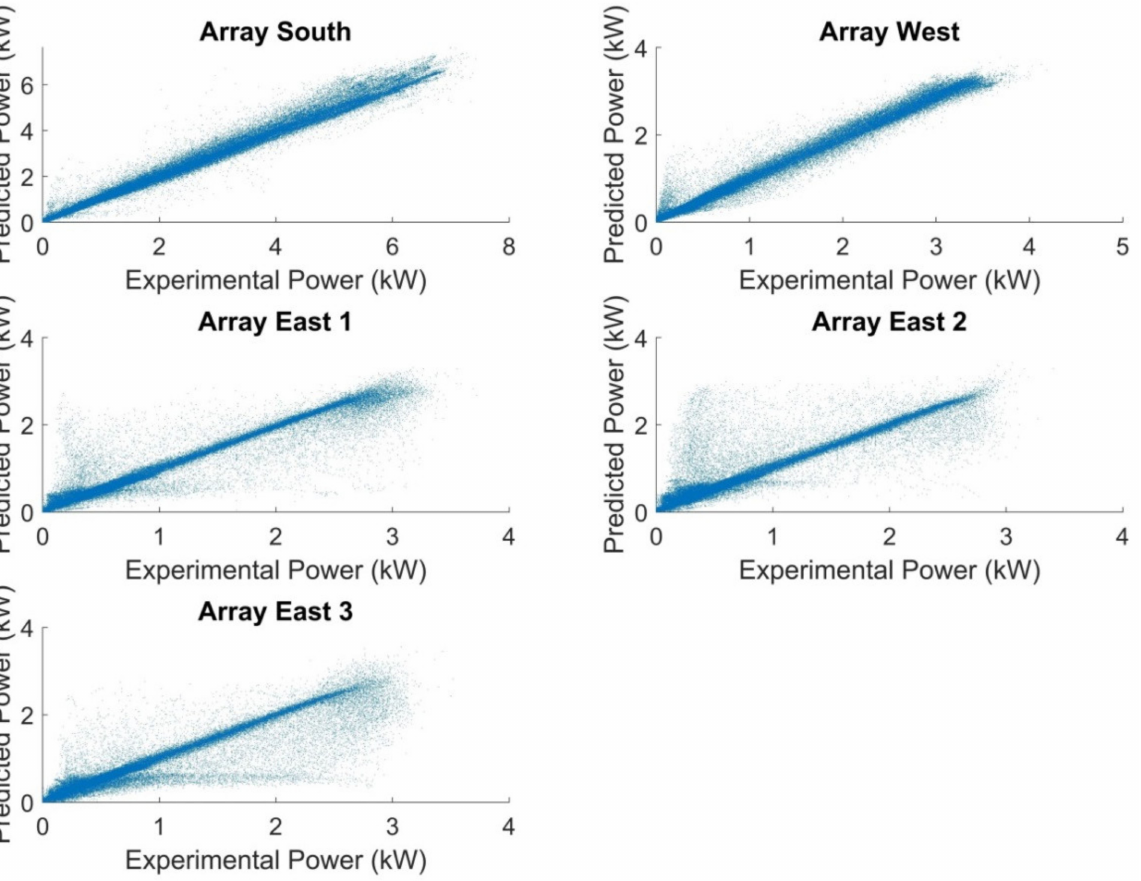
Figure 7. Scatter plots of modeling PV power in BIPV arrays for the period from January 2019 to December